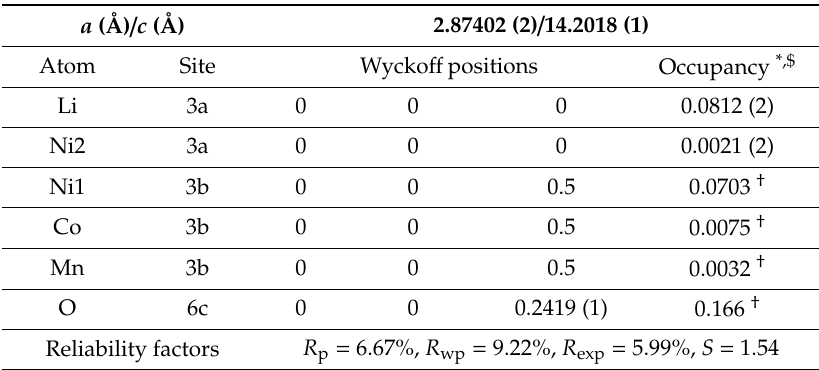
Table 1. Structural parameters and reliability factors estimated from Rietveld refinement of the high- resolution powder diffraction (HRPD) pattern of the NMC811 cathode material prior to electrochemical testing.